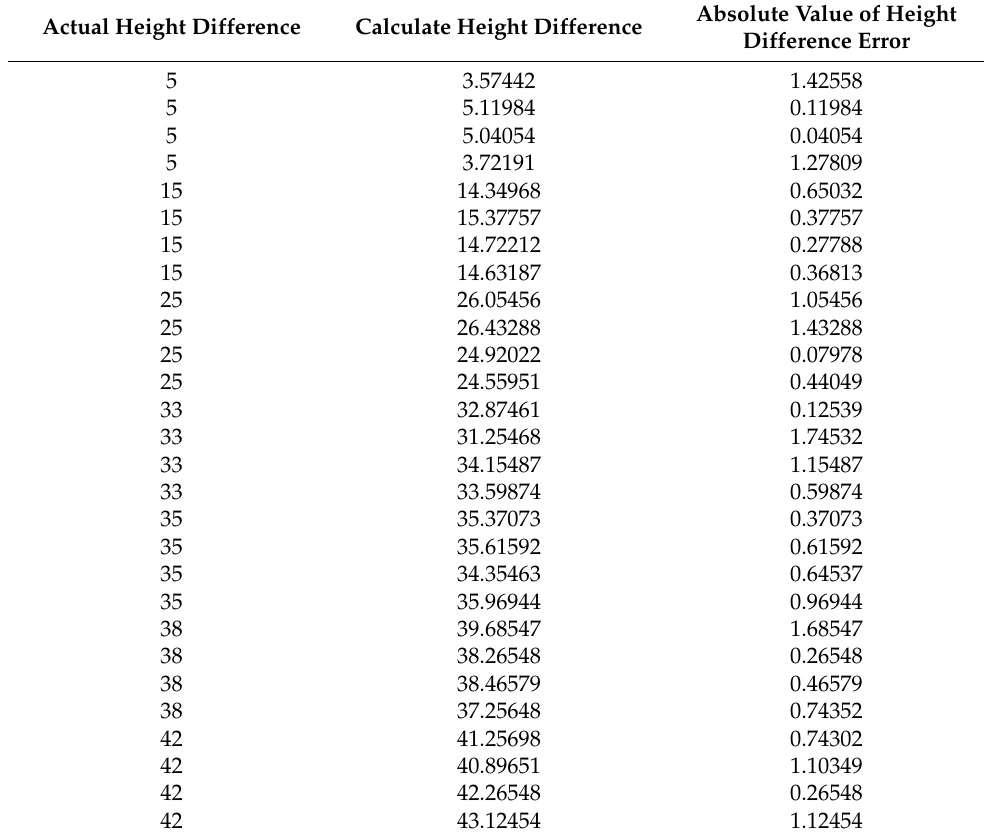
Table 2. Height-difference calculation based on modeling